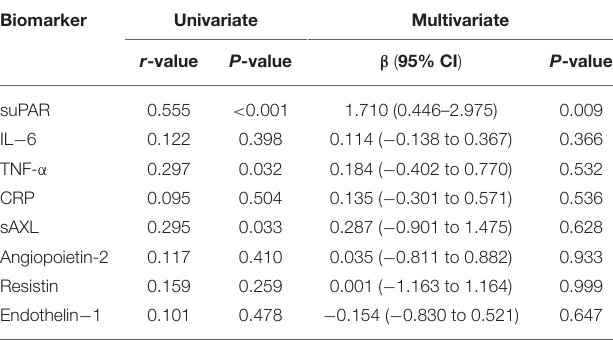
TABLE 3 | Univariate and Multivariate associations between biomarkers and GLS. Biomarker